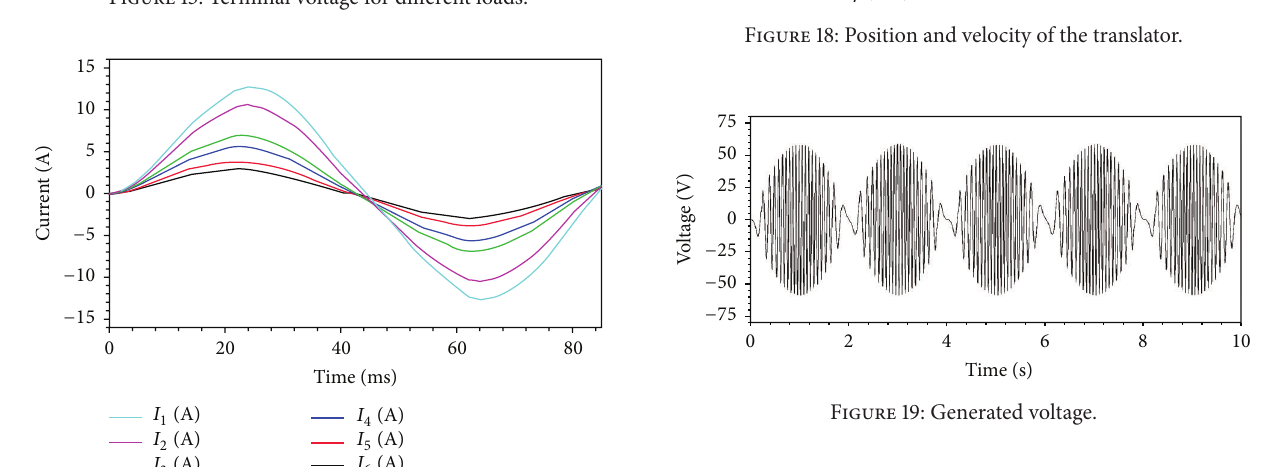
Figure 16: Load currents for different loads.